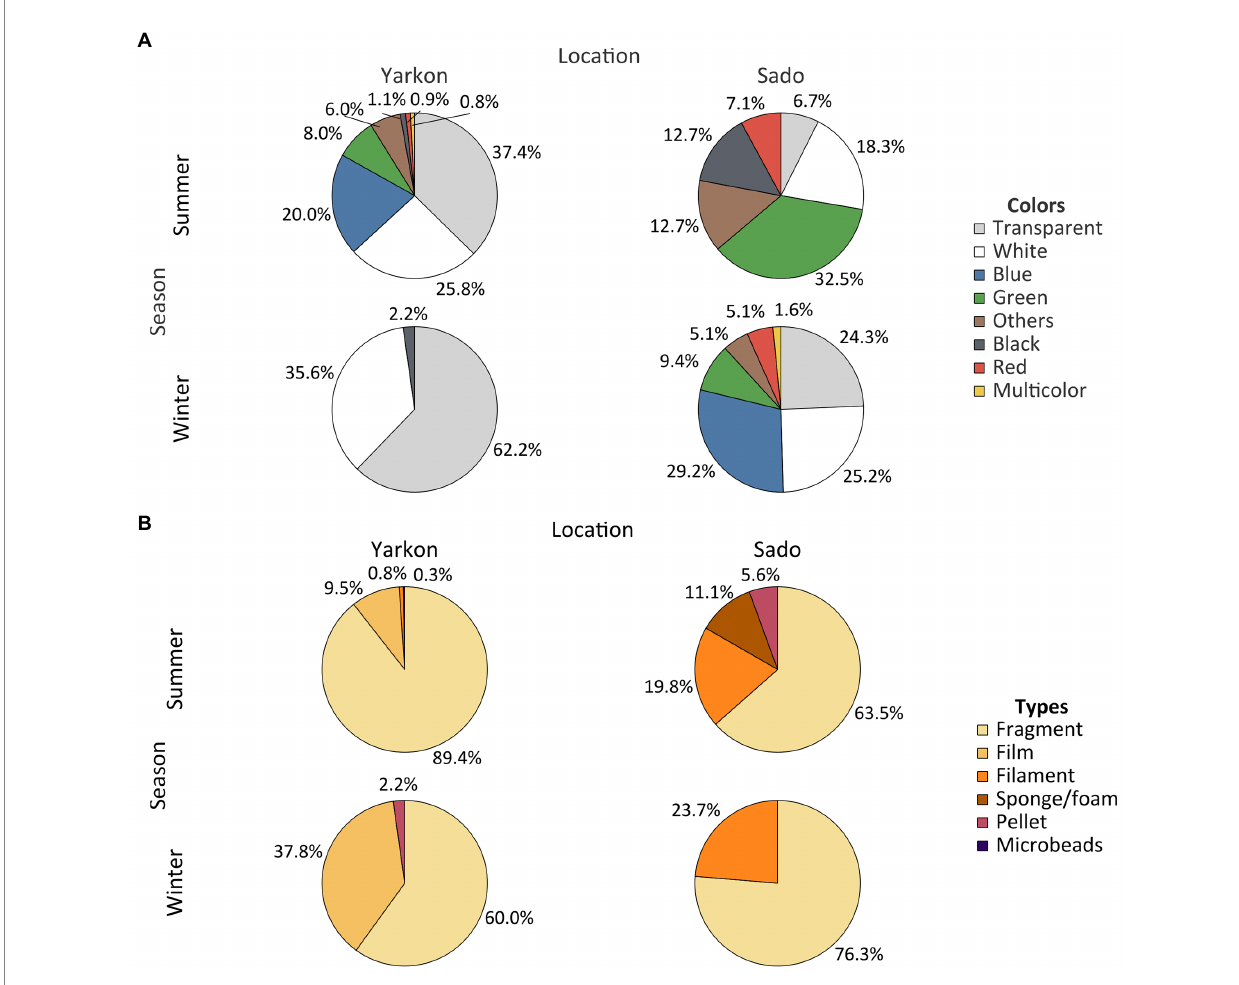
FIGURE 2 Physical characteristics of the microplastic. (A) Plastic abundances by color in both locations and seasons. (B) Abundance of plastic types in both locations and seasons. Results are expressed in % of polymers relative to total microplastics